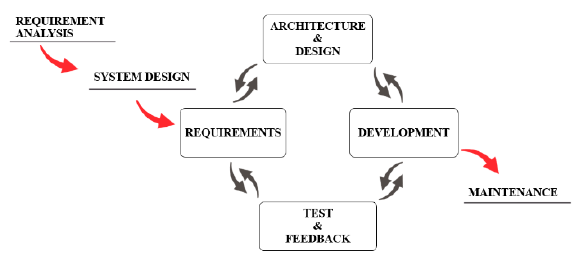
Figure 1. Hybrid agile-waterfall methodology approach.